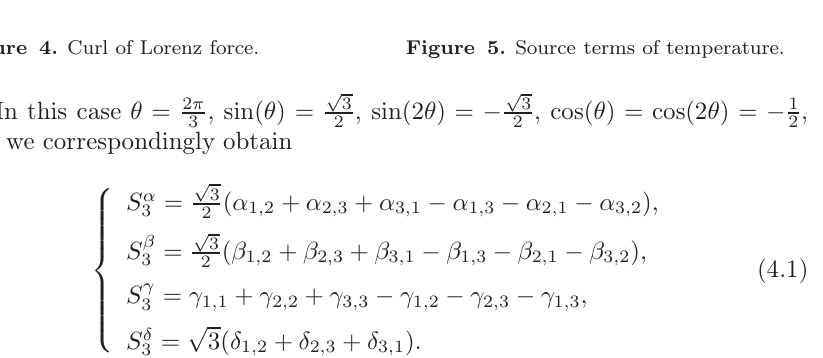
Figure 4. Curl of Lorenz force. Figure 5. Source terms of